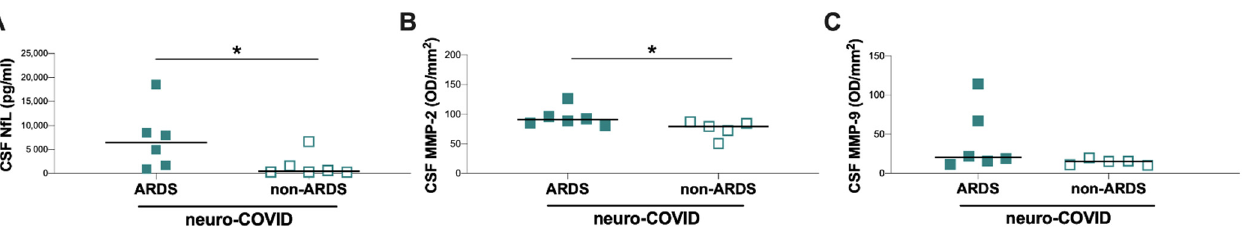
Figure 3. Evaluation of CSF NfL, MMP-2, and MMP-9 levels in neuro-COVID group. ( A ) Evaluation of CSF NfL levels in COVID-19 patients with severe neurological symptoms (neuro-COVID group) stratified according to ARDS development. ( B ) Evaluation of CSF MMP-2 levels in COVID-19 patients with neurological symptoms (neuro-COVID group) stratified according to ARDS development. ( C ) Evaluation of CSF MMP-9 levels in COVID-19 patients with neurological symptoms (neuro-COVID group) stratified according to ARDS development. Horizontal lines represent medians. Neuro-COVID group: COVID-19 patients with severe neurological symptoms; NfL: neurofilament light chain; HD: healthy donors; ARDS: acute respiratory distress syndrome; CSF: cerebrospinal fluid; MMP-2: matrix metalloprotease-2; MMP-9: matrix metalloprotease-9; OD: optical density. *: 0.01 < p < 0.05.